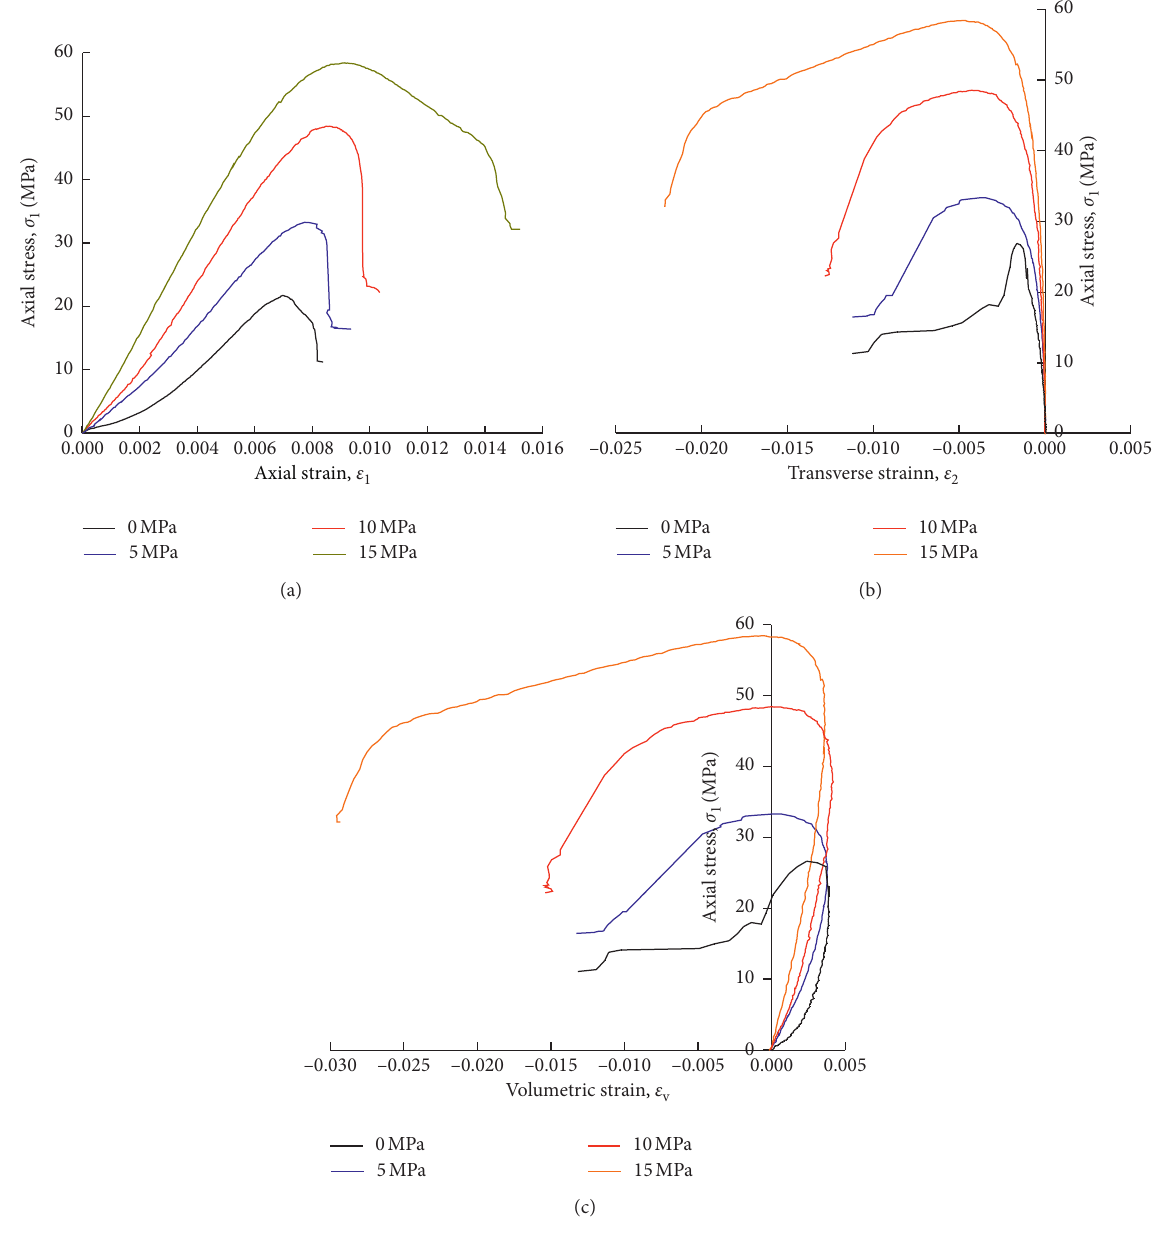
Figure 3: Stress-strain curves of weak cementation sandstone under different confining pressures: (a) axial stress curve, (b) transverse stress curve, and (c) volume stress